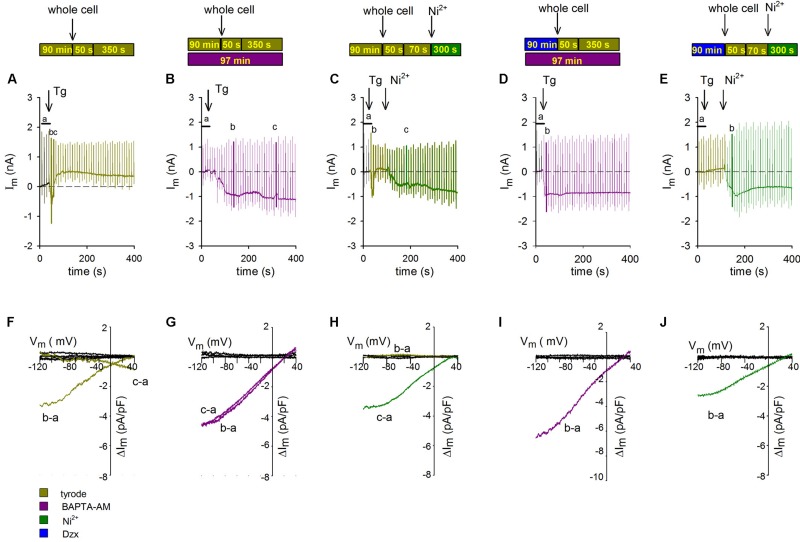
Inactivation of SOCs by voltage ramps is prevented by Ca2+ chelation with BAPTA-AM or NCX blockade with Ni2+. The experimental protocol employed for each experiment is summarized above the data associated with that experiment. Voltage ramps were delivered every 10 s with an HP of –80 mV. The additions of Tg and Ni2+ are indicated with arrows. (A–C) Representative continuous recordings of membrane currents in a control non-PPC cardiomyocyte (A), a non-PPC cardiomyocyte preincubated with BAPTA-AM (B), a non-PPC cardiomyocyte treated with Ni2+
(C), a PPC cardiomyocyte preincubated with BAPTA-AM (D), and a PPC cardiomyocyte treated with Tg and Ni2+
(E). (F–J) I–V relationships of subtracted currents from the experiments illustrated in panels (A–E). The average current upon control ramp application (indicated by the letter a) was subtracted from the currents upon the application of selected ramps, which are indicated by the letters b and c in panels (A–E). Average control currents during ramps (black lines) were also subtracted from each individual control current.